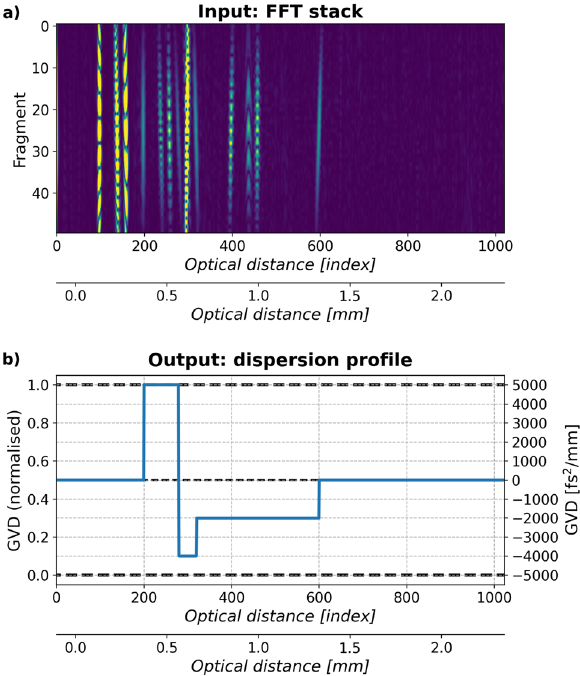
Figure 1. ( a ) The input of the neural network is an FFT stack which is calculated from a raw experimental spectrum. The training FFT stacks are calculated from computer-generated spectra. ( b ) The output is a 2 dispersion profile, i.e. the GVD value distribution within the object in an A-scan. GVD equal to 0 fs /mm corresponds to 0.5 in the dispersion profile, and the maximum and minimum GVD values used for training, 2 5000 and −5000 fs /mm correspond to 1 and 0 in the dispersion profile. The presented object has four interfaces placed at the positions 200, 280, 320 and 600 corresponding to the distance from zero optical distance equal to 2 218 μm and the object layers thicknesses of 87, 44 and 306 μm. The GVD value is 0 fs /mm for the area in front 2 of the object and 5000, − 4000 , and − 2000 fs /mm for the object